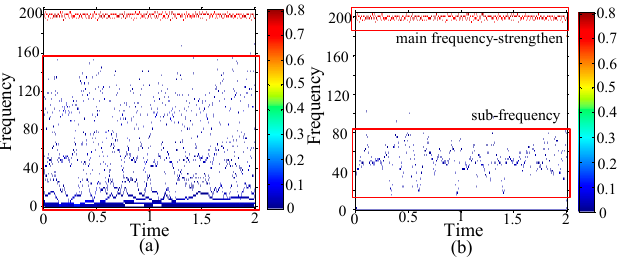
Figure 22. One 0.5 mm hole on outer race ( a ) HHT ( b ) GEMD-HHT spectrum.